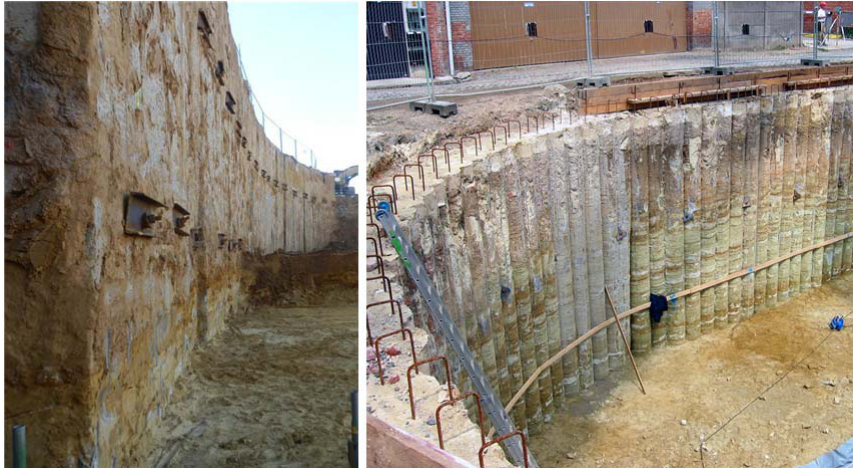
Figure 2. Soil mix retaining walls within the framework of excavation works in Belgium: soil mix walls built with CSM ‐ panels (left) and with the C ‐ mix shaft system of CVR nv (right) .